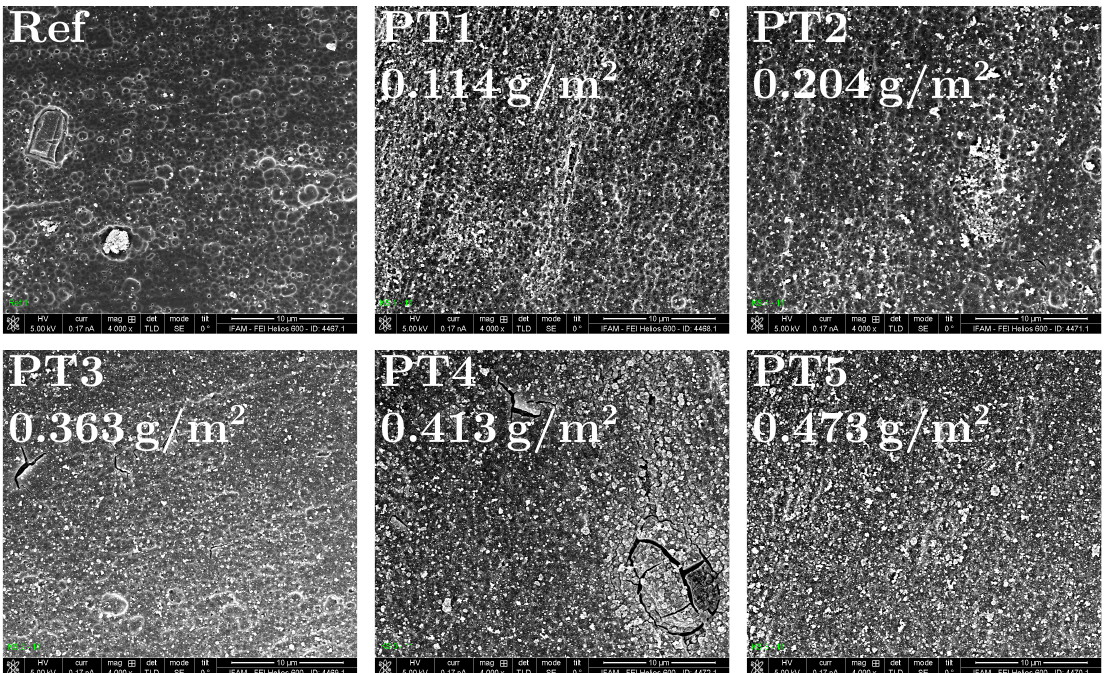
Figure A1. SEM images of all samples taken with a magnification of 4000 times are shown. An overview of the reference and coated specimens with applied coating weight is given.